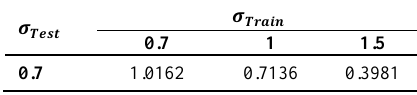
Table 5. MSE of model for KA test data in noisy condition.